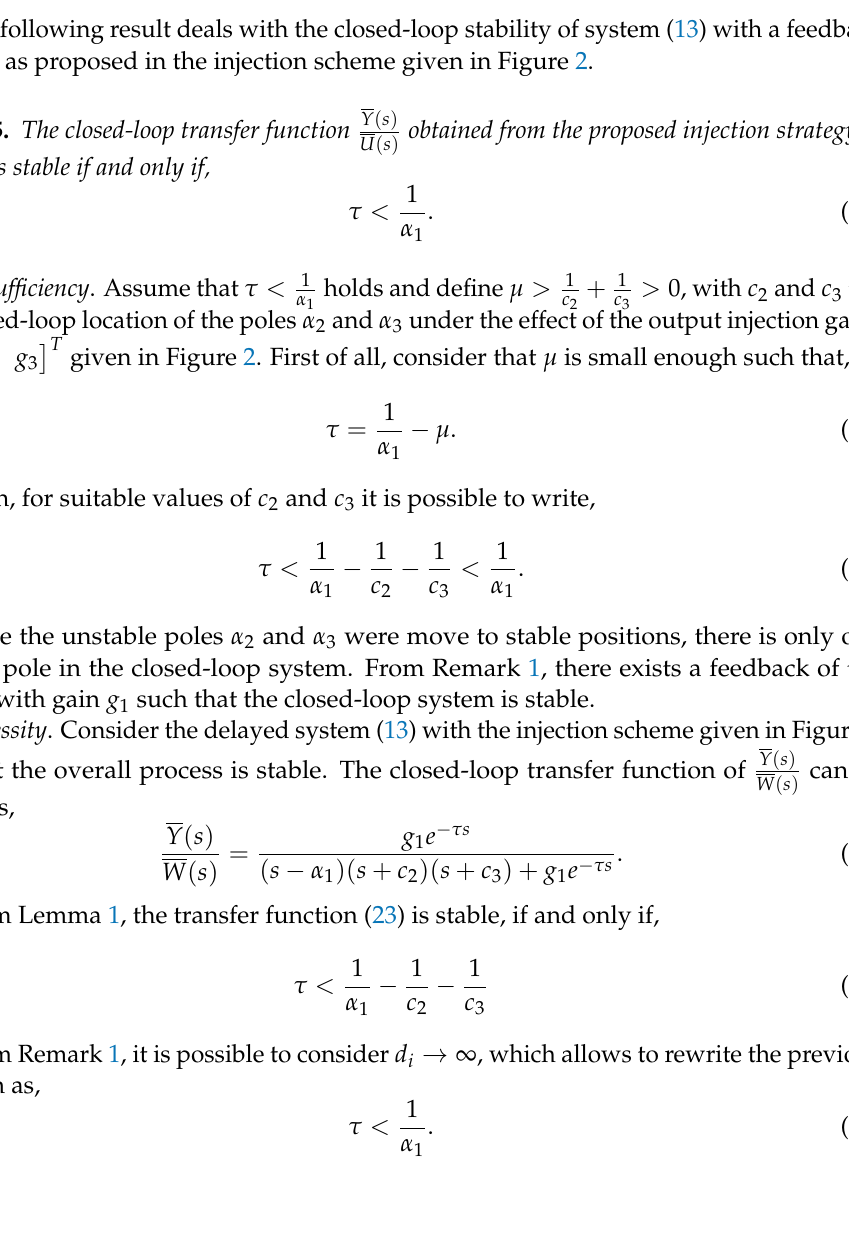
Figure 2. Proposed injection scheme. Three unstable poles